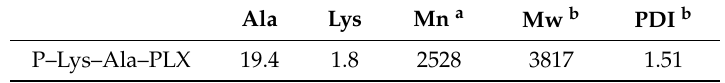
Figure 1. ( A ) 1 H-NMR of poloxamer (PLX)-poly( l -alanine-lysine) (P–Lys–Ala–PLX) copolymer in trifluoroacetic acid-d (TFA-d). ( B ) FT-IR spectra of P–Lys–Ala–PLX (red line) and PLX (black line) samples obtained via an attenuated total reflectance (ATR) module (2900 cm − 1 , alkane of Pluronic F-127; 3345 cm − 1 , amide of poly( l -alanine) and poly( l -lysine); 1637 cm − 1 and 1540 cm − 1 , amide I and II of poly( l -alanine) and poly( l -lysine); 1100 cm − 1 , carbon-oxygen bond of PLX. Table 1. The molecular weight and polydispersity as determined by GPC and 1 H NMR.